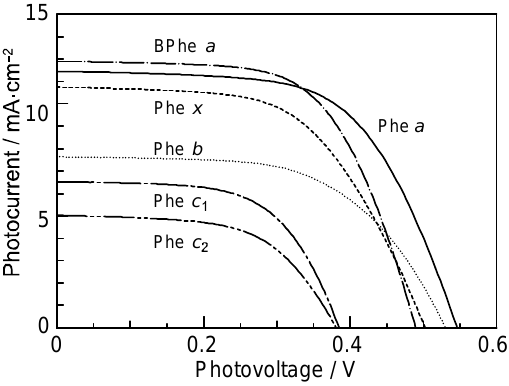
Figure 34. The I–V curves of solar cells using BPhe a , Phe a , Phe x , Phe b , Phe c sensitizers (reprinted with permission from [20] © 2008, American Chemical Society). c 2